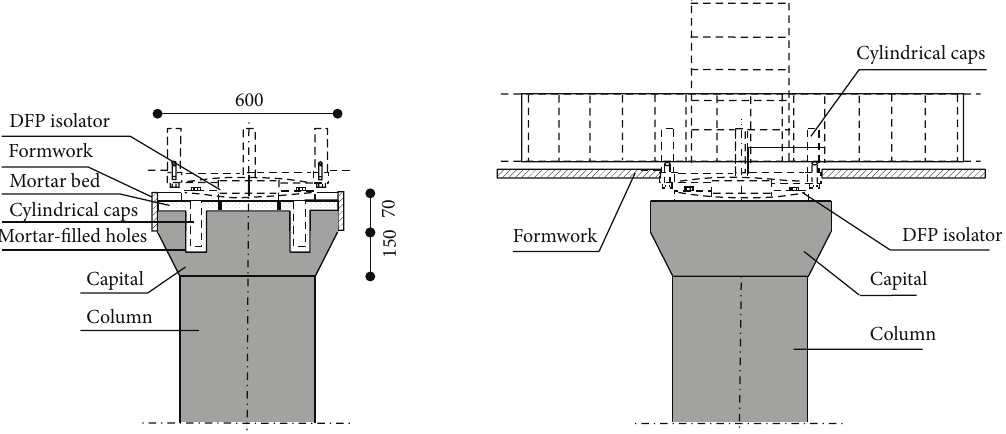
Figure 13: Design drawings concerning the installation details of a DFP isolator over a column.